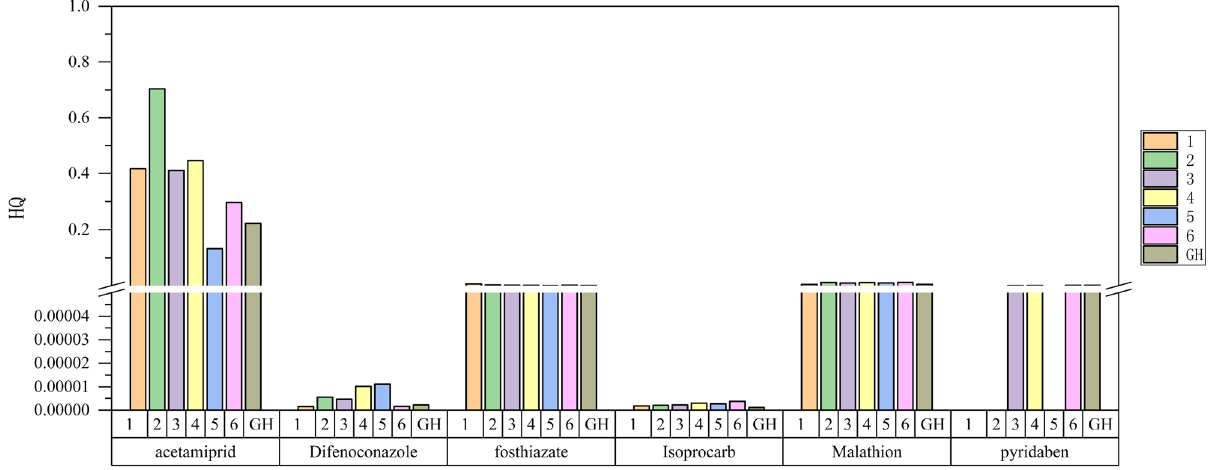
Figure 3. Lifetime non-cancer risk of 7 households exposed to a certain pesticide alone in agricultural areas.